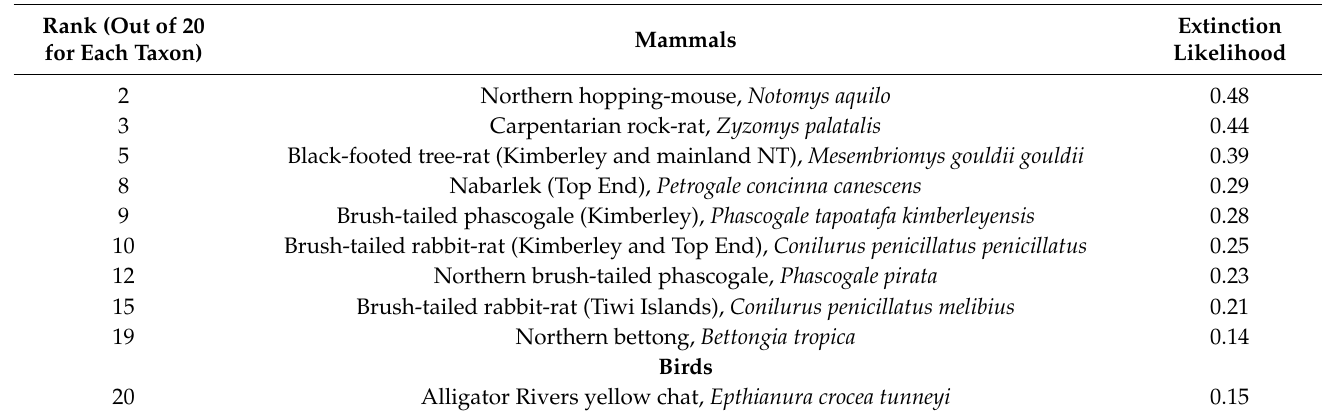
Table 2. The likelihood of extinction in the next 20 years for northern mammals and birds considered most imperiled (extract from Table 1 of